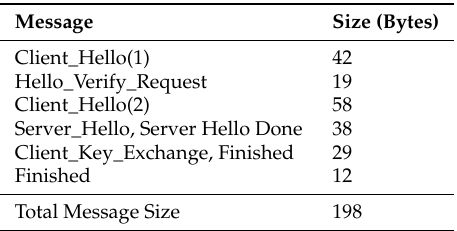
Table 6. DTLS–PSK handshake message packet.